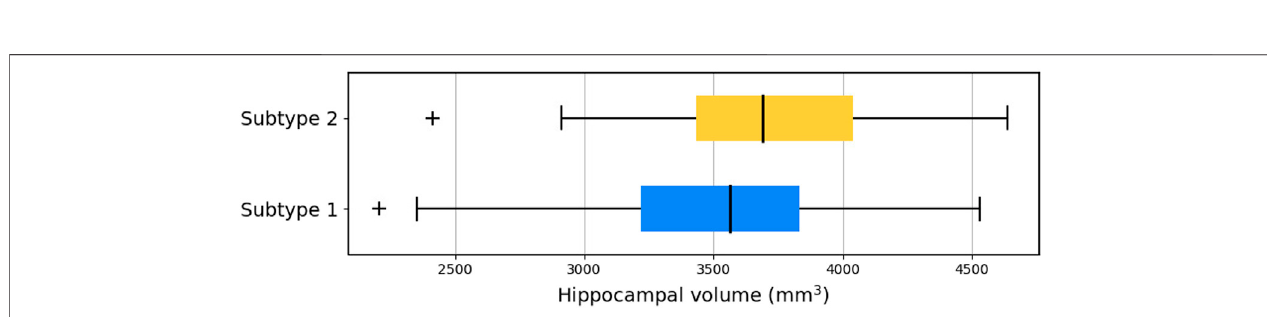
FIGURE 3 | Hippocampal volume of subjects from Subtypes 1 and 2 labeled with minimal atrophy according to AVRA scores. Hippocampal volumes were averaged between right and left hemisphere for simpler representation.